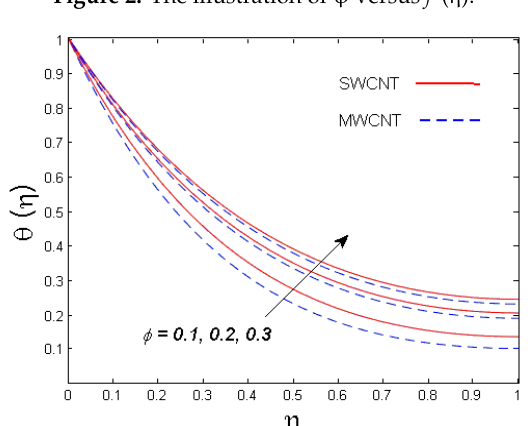
Figure 3. The illustration of φ versus θ(η).